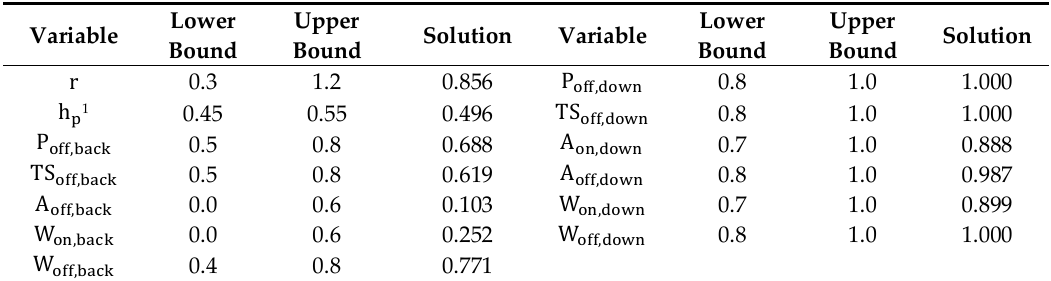
Table 1. Biomechanical optimization